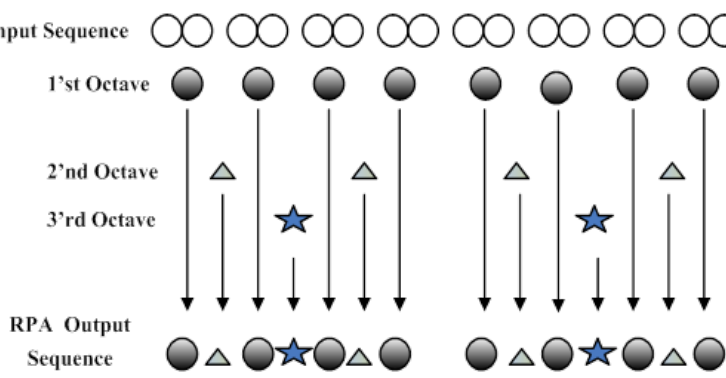
Figure 7. Scheduling diagram for the